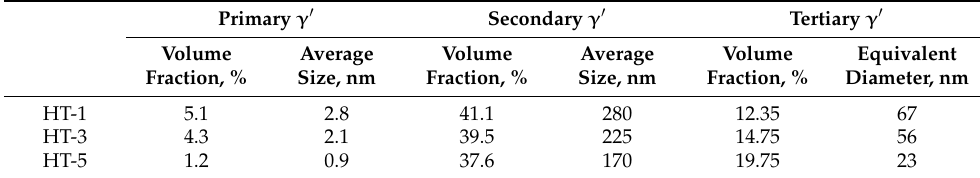
Table 5. Characteristics of γ (cid:48) phase in FGH4107. Primary γ